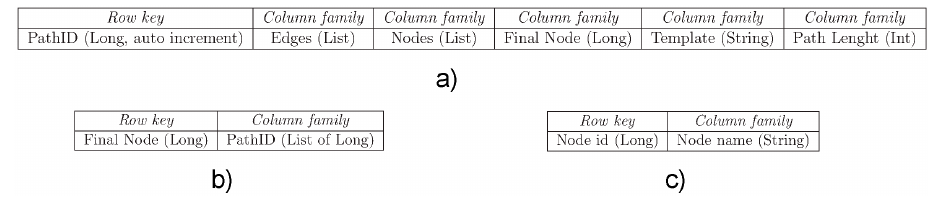
Figure 7. HBase configuration for the running experiment: ( a ) table Path; ( b ) table Sink-PathID; ( c ) table Node-Label.